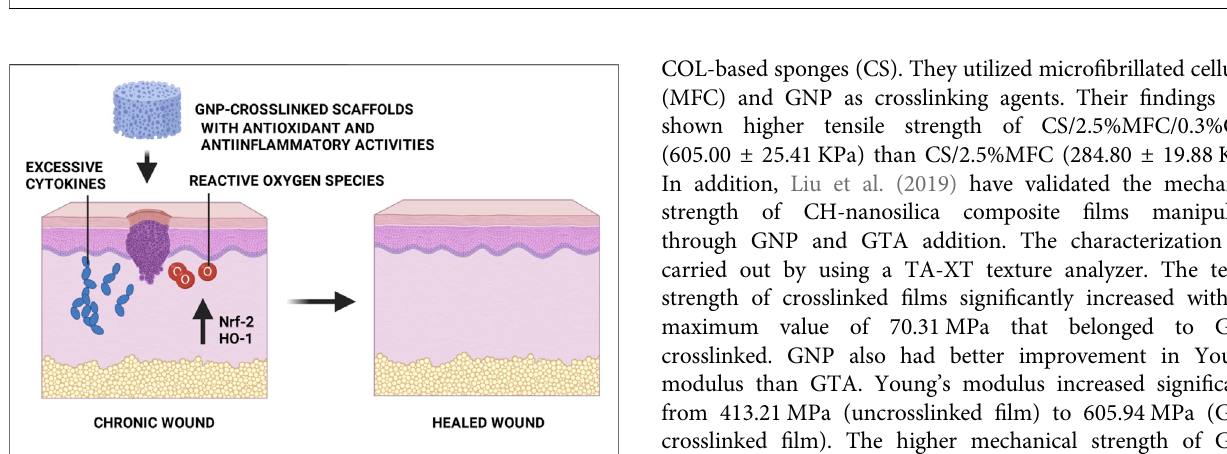
FIGURE 7 | No toxicity of GNP-crosslinked scaffolds. Several studies have proven the survival of human skin cells in the culture during GNP-crosslinked intervention.